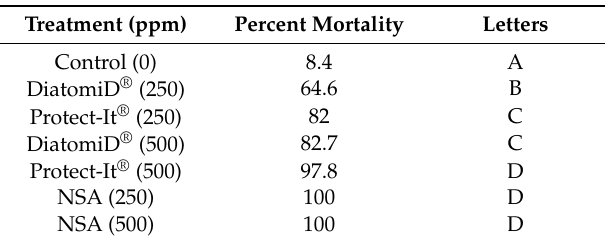
Table 1. Overall mortality of Sitophilus oryzae from laboratory efficacy tests-dry dust application of nanostructured alumina (NSA) and diatomaceous earth (DE).